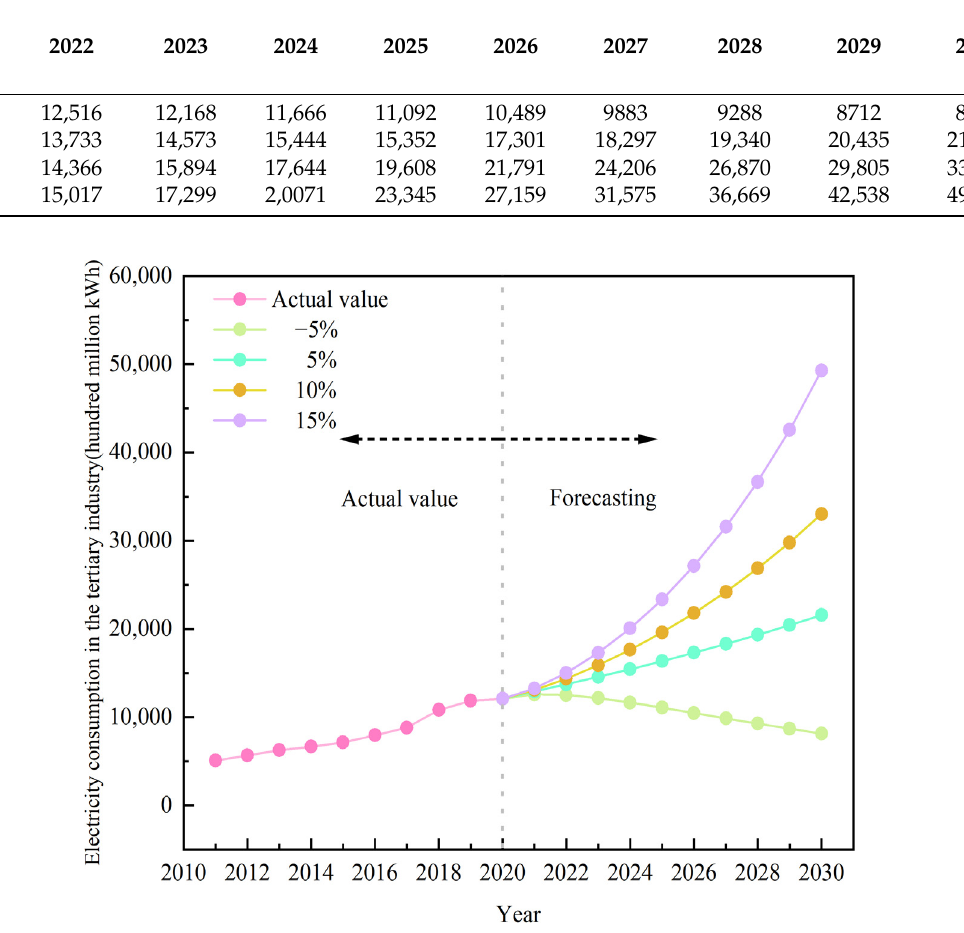
Table 6. Predicted power consumption of the tertiary industry under different growth rates.